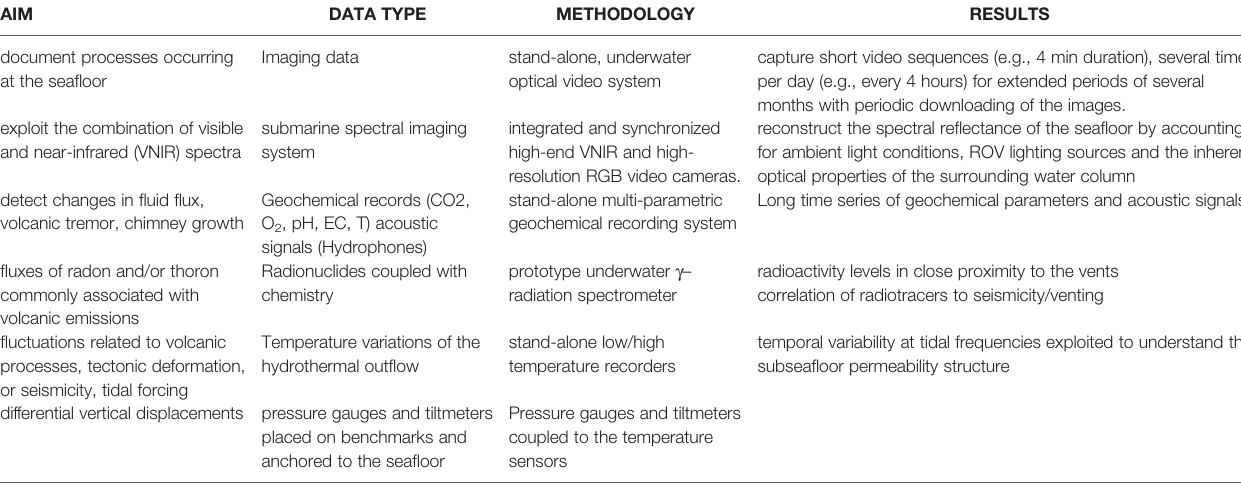
TABLE 1 | Activities to be performed in SANTORY by continuous measurements.